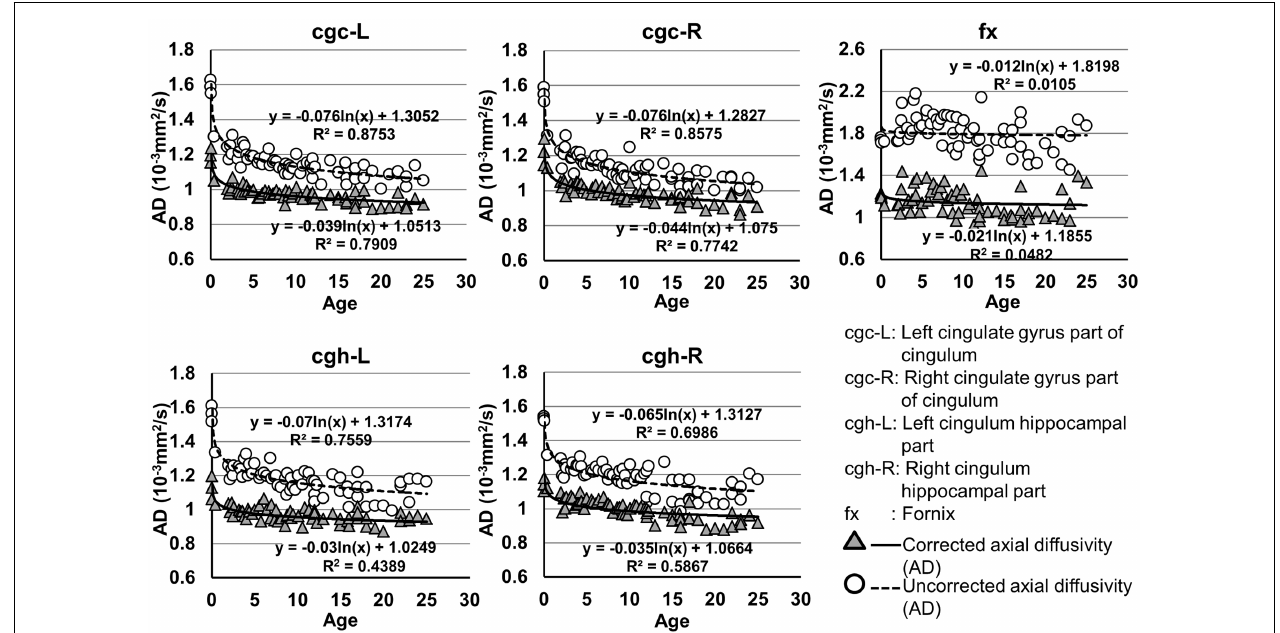
FIGURE 5 |Age-dependent changes of uncorrected and corrected axial diffusivity (AD) measurements of limbic tracts . R 2 and fitting equations are listed in each panel.